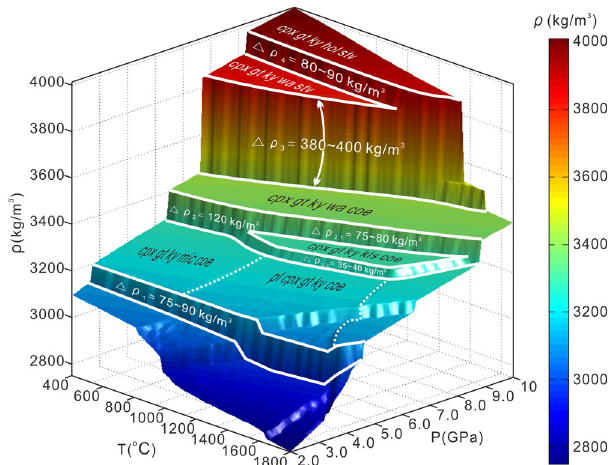
Table 2). After collision, the Greater India-derived continental felsic crust is mainly preserved in the Himalaya fold-thrust belt 11 .